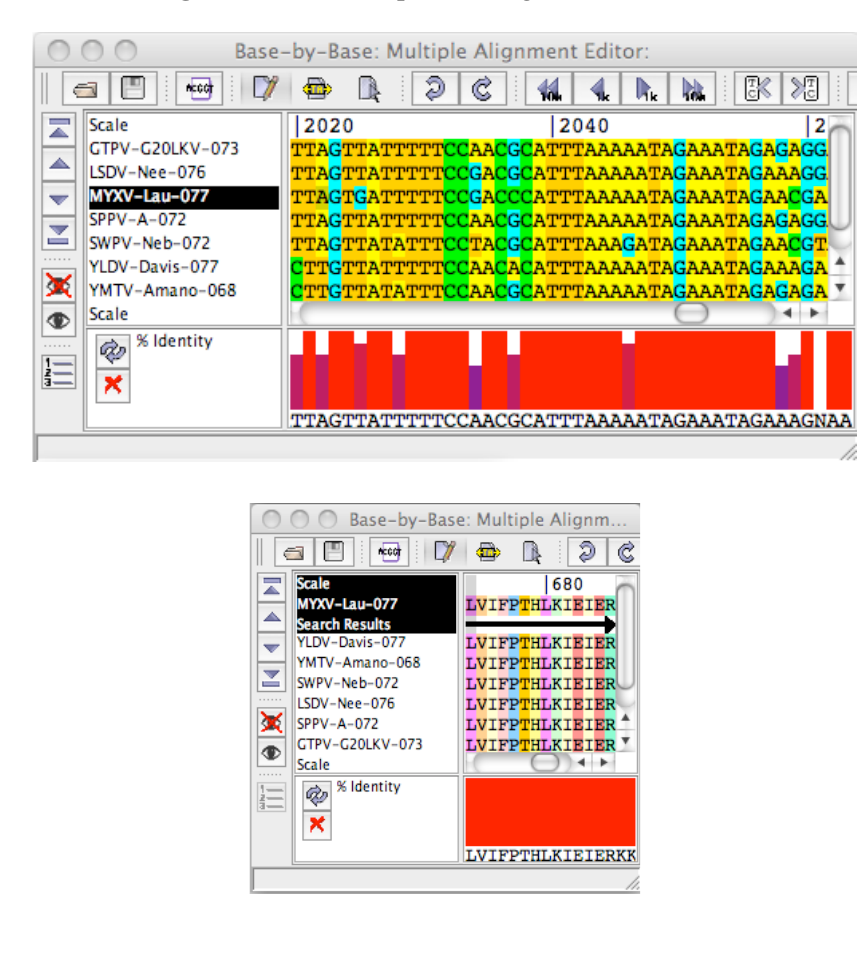
Figure 8. DNA and protein alignments of